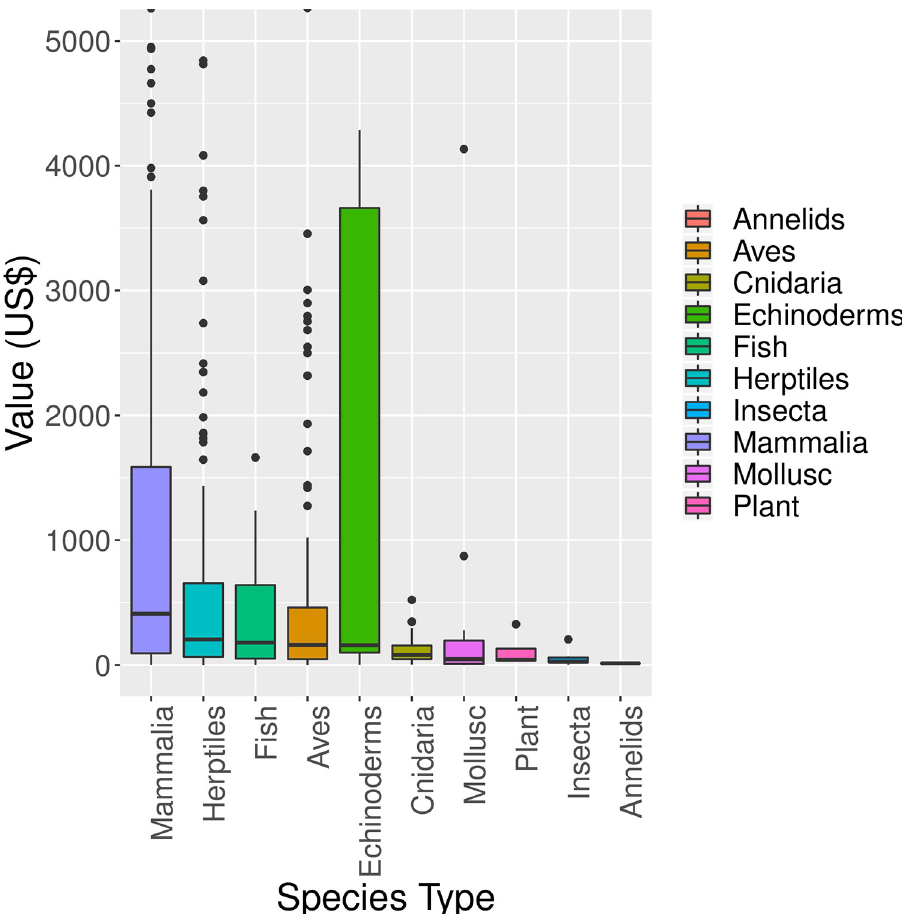
Fig 3. Boxplots depicting average price of seizures into the USA by taxa. Values beyond US$ 5000 are not shown.